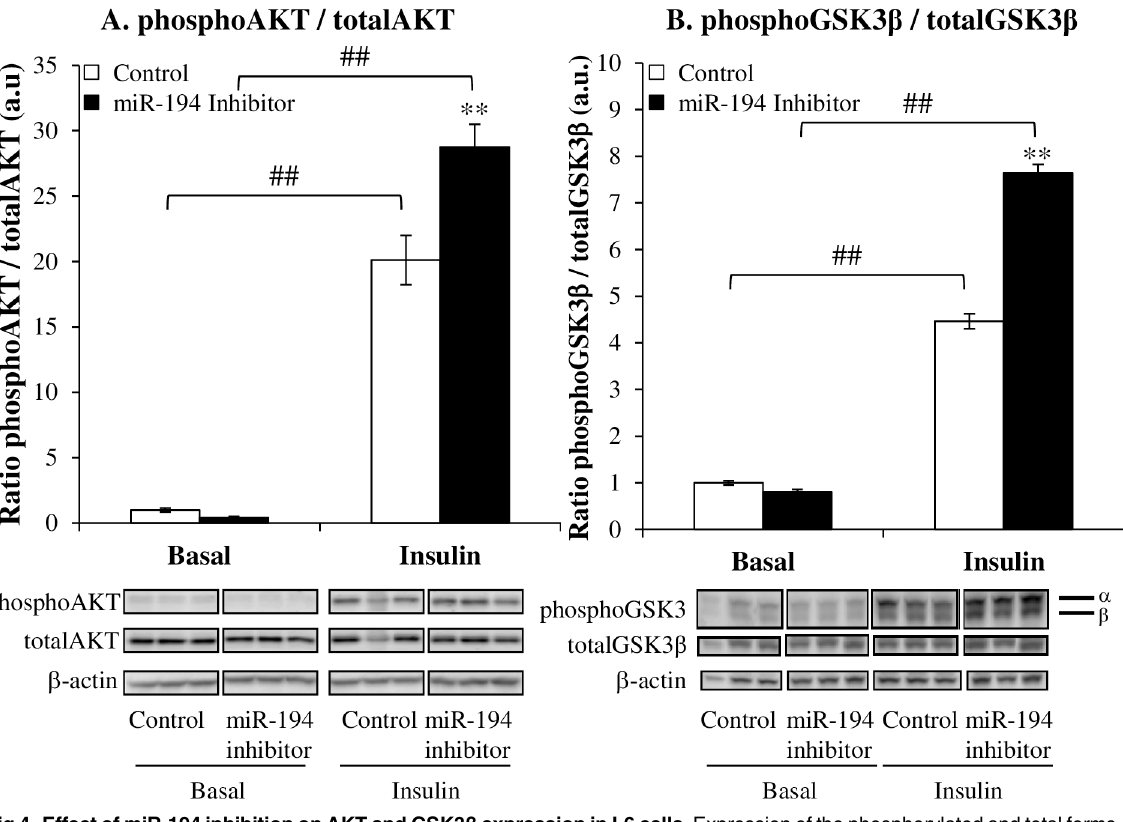
Fig 4. Effect of miR-194 inhibition on AKT and GSK3 β expression in L6 cells. Expression of the phosphorylated and total forms of AKT (A) and GSK3 β (B) were measured by Western blot in L6 cells 48 hours after transfection with a miR-194 inhibitor. Ratios phosphorylated:total are expressed as mean ± SEM (n = 3 per group). Representative blots are shown below the graphs. P -values were determined using 2-way ANOVA (normally distributed data) or Kruskal-Wallis 1-way ANOVA on ranks (non-normally distributed data) followed by Student-Newman-Keuls post-hoc tests ( * p < 0.05 vs. control, # p < 0.05 vs.